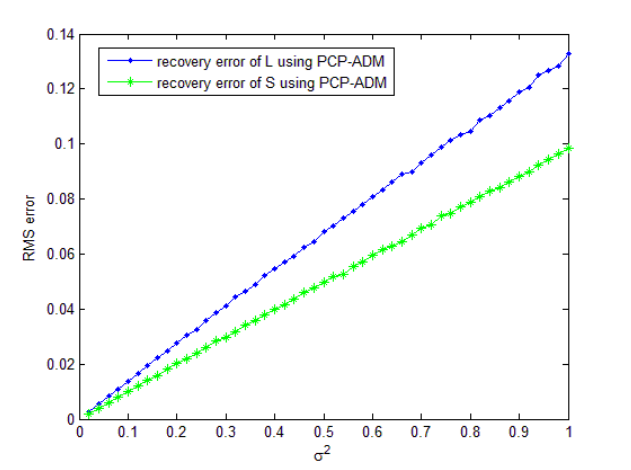
Figure 1. Root-mean-squared (RMS) errors as a function of σ 2 with r = 10; ρ s = 0.01; n = 200. PCP-ADM: Principal Component Pursuit by Alternating Direction